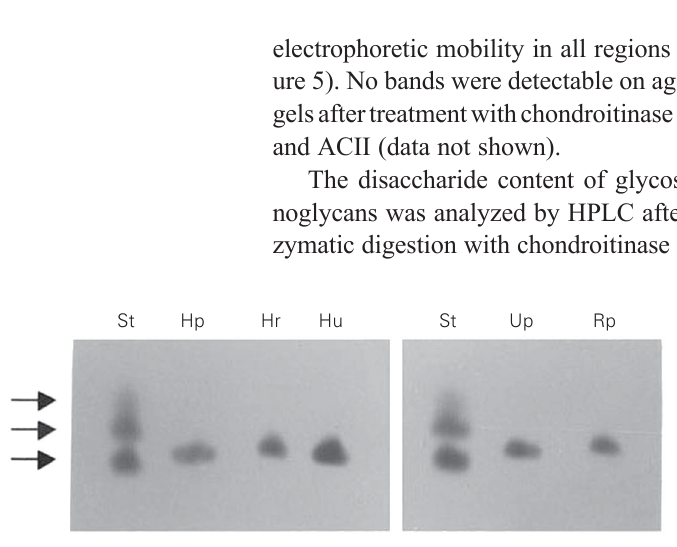
5. Analysis of glycosaminoglycans by propylenediamine agarose gel electrophore- sis. Chondroitin sulfate is the main glycosaminoglycan. Standards (St) of chondroitin sulfate (CS), dermatan sulfate (DS), and heparan sulfate (HS) were used. The gel